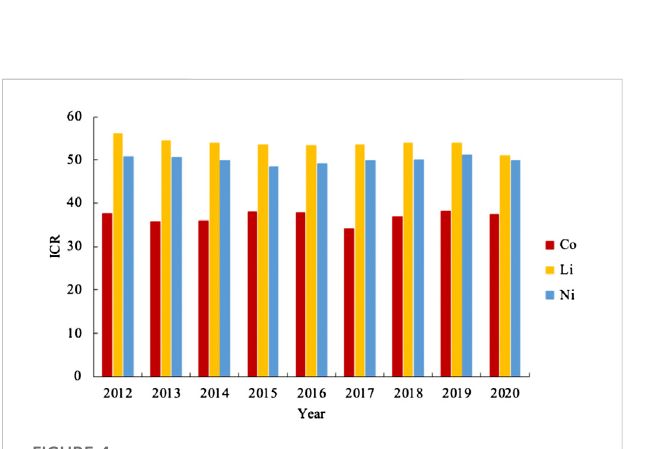
FIGURE 6 Bilateral institutional distance between China and critical mineral source countries.